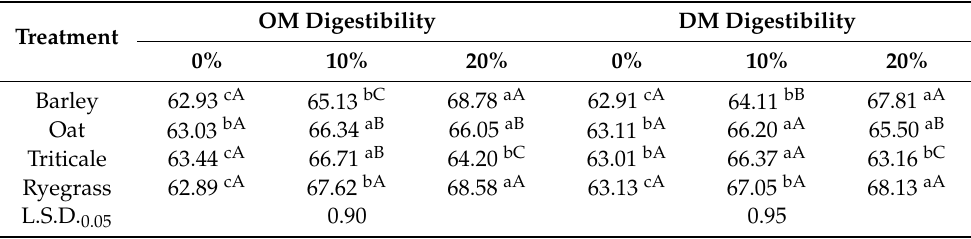
Table 5. Means of the digestibility (%) of the organic matter (OM) and dry matter (DM) as affected by the interaction between the crop and its percentage in the